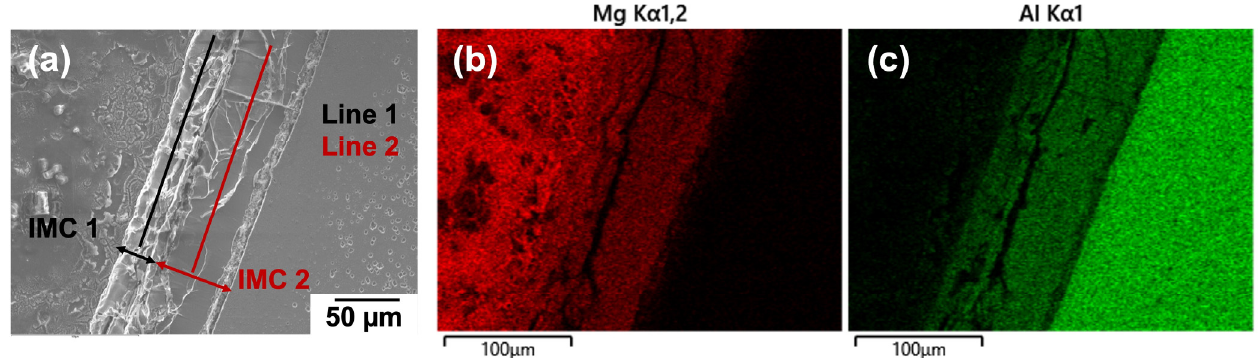
Figure 7. ( a ) SEM-SE image of diffusion bonded 6022 Al and ZEK100 Mg; ( b ) Mg and ( c ) Al are the respective EDS mapping of ( a ), which shows two intermetallic layers. Table 2. Index of EDS line-scan results from Figure 7a.